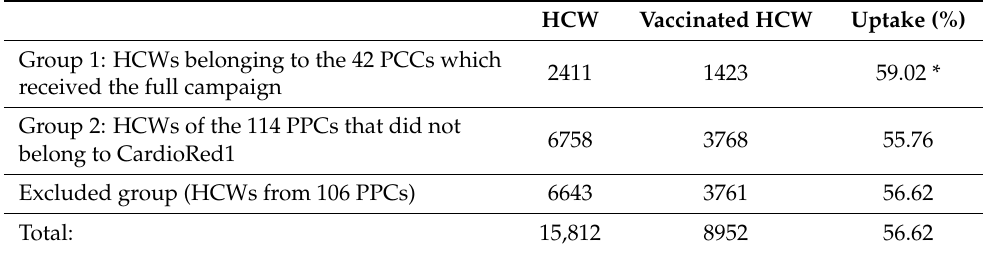
Table 3. Influenza vaccination rates in HCWs by